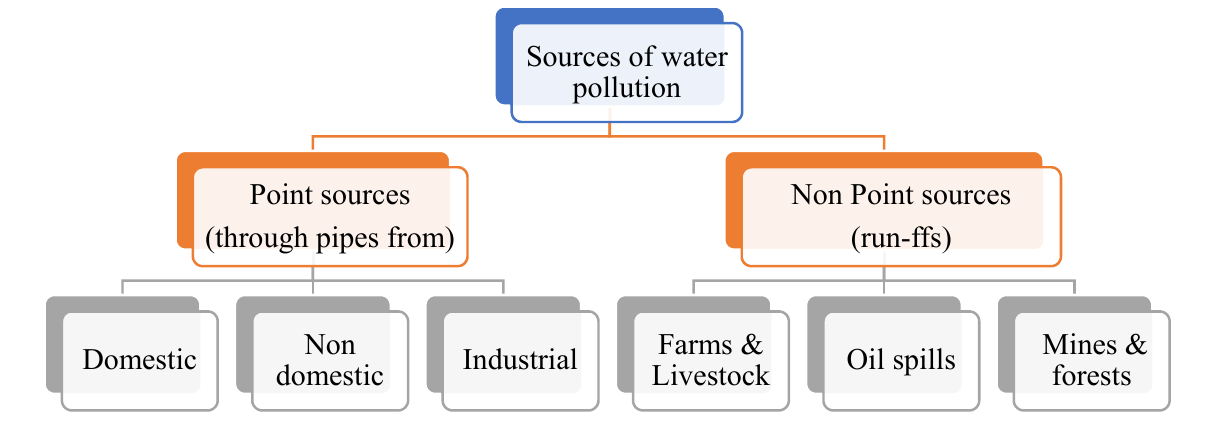
Figure 2. Sources of Water Pollution. Table 1. Sources of water pollution along with their side